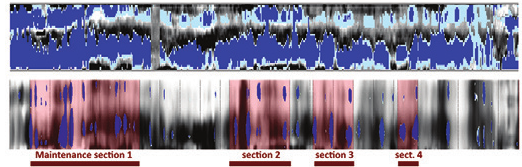
Fig. 11. Comparison of water accumulation places obtained from cross-sections (above) and 2D pavement surface models